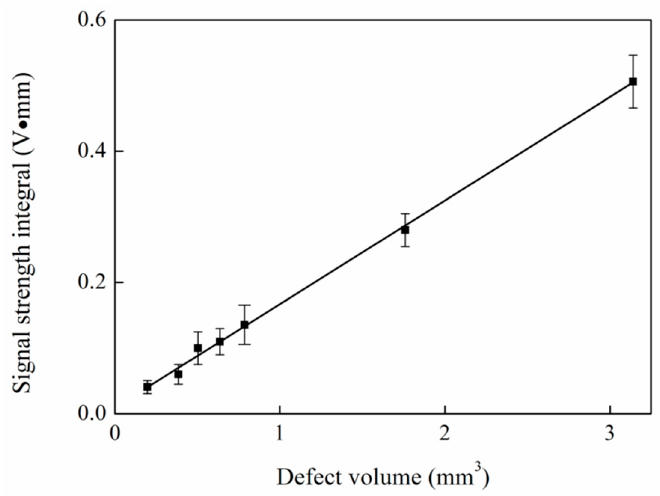
Figure 8. The voltage signal strength integral value in the z -direction as indicated in Figure 7a, varies approximately linearly with the different defect volumes.